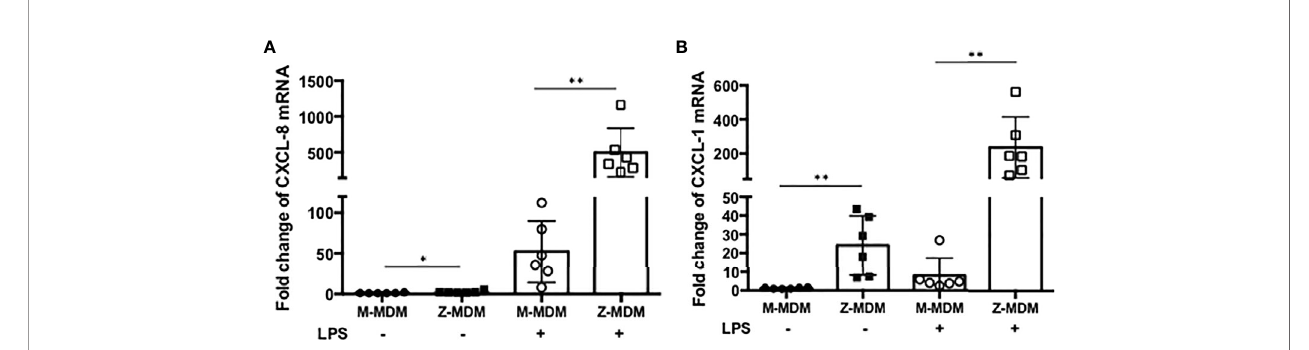
FIGURE 2 | LPS-induced neutrophil chemoattractant expression in M- and Z-MDMs. MDMs were incubated with LPS (10 ng/ml) overnight and the expression levels of (A) CXCL-8 and (B) CXCL-1 were compared between M- and Z-MDMs (n=6). The expression levels of the cytokines were normalized to GNB2L1, housekeeping gene.* and **Denote statistical signi fi cance (p-value < 0.05 and p-value < 0.01, respectively) according to two-tailed Student ’ s t-test.